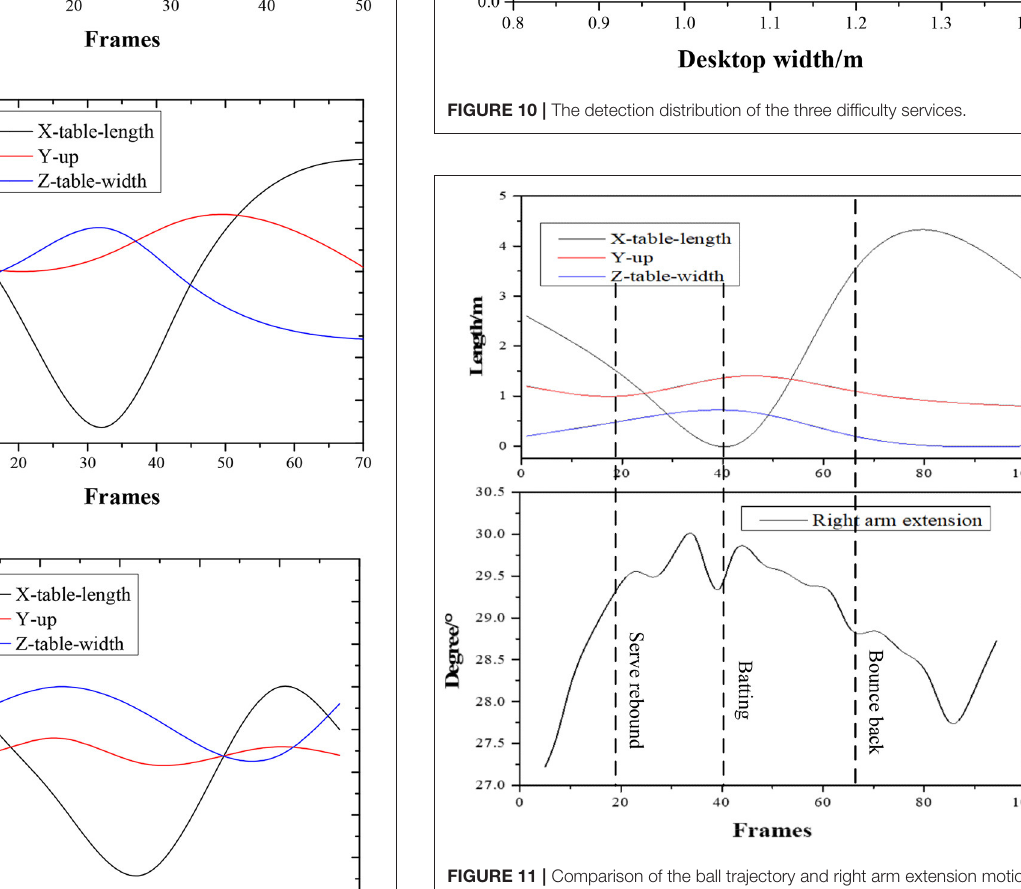
FIGURE 9 | (A) Table tennis trajectory of missed receiving. (B) Table tennis trajectory of receiving the ball out of the table. (C) Table tennis trajectory of receiving the ball touching the net.